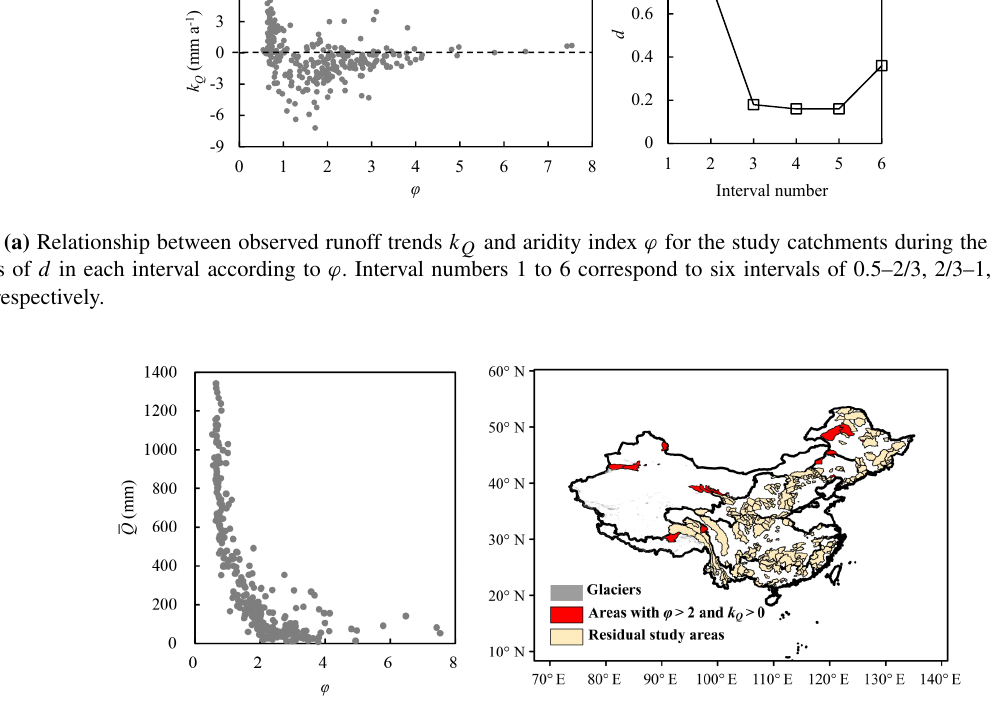
Figure 6. (a) Relationship between mean annual runoff Q and aridity index ϕ in the study catchments during the period 1956–2000. (b) Distribution of catchments with ϕ > 2 and k Q > 0. Presenting glaciers are based on the second glacier inventory data set of China (Guo et al.,